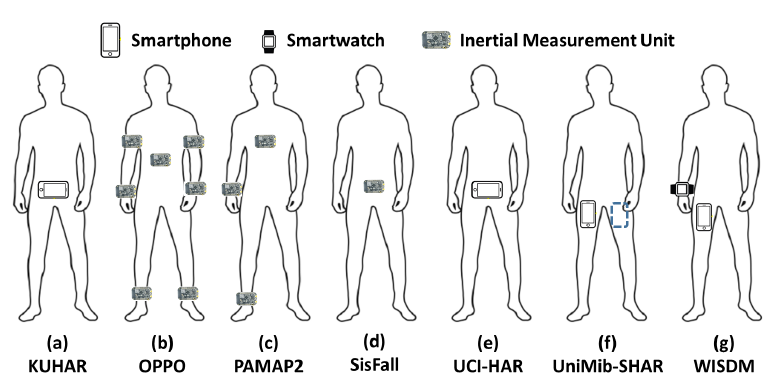
Figure 2. Sensor placement on the subject’s body. A waist-mounted smartphone was used for KUHAR, UCI-HAR, and WISDOM. WISDOM was collected using additional smartwatches. IMU units were used to collect the signals for OPPO (positions: back, right/left upper/lateral parts of the arm and right/left shoe ), PAMAP2 (positions: chest, wrist, and ankle), and Sis-Fall (position: